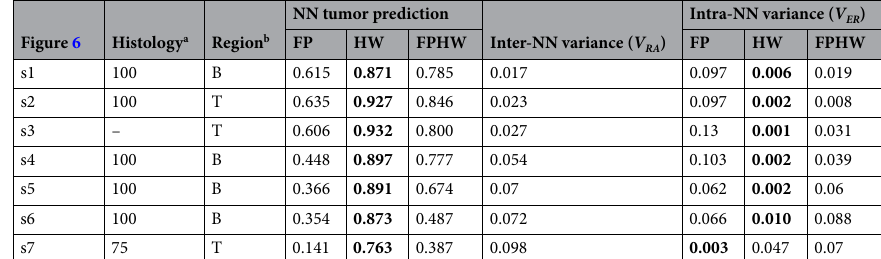
Table 6. Using variance in predicted tumor likelihood amongst the three NN configurations (inter-NN variance, V ER ) to identify tumors predicted by at least one but not all NNs. Significant inter-NN variance (see Fig. 5B, V ER > 1σ) occurred in 7 targets, all from tumor or boundary regions. The highest NN tumor probability for each target appears in bold. NNs using only FP inputs predicts 3 of these targets contain tumor, but with relatively low probabilities ( P Tumor = 0.62 ± 0.02, N = 3). FPHW using the full nine inputs predicts 5 of the 7 targets contain tumor and produces higher probabilities ( P Tumor = 0.78 ± 0.06, N = 5). The NNs trained only on HW data predict all 7 of these targets contain tumor. HW NNs generated the highest tumor likelihood probabilities ( P Tumor = 0.88 ± 0.06, N = 3). The variation in the output of each stochastic NN (train-test cycle repeated 10 times with random weight restarts) provides an intra-NN variance or V RA for each of the three NN configurations. Six of the seven HW NNs exhibits the least variance in their predictions (V RA between 0.001 and 0.10). One a single target (s7) NN FP exhibits minimal variance across ten trials ( V RA ~ 0.003) while generating a low tumor probability ( P ~ 0.141). For target s7 HW predicts a tumor likelihood of P ~ 0.763 with V RA = 0.047. a Pathologist target labels in Fig. 6. Pathologist estimate of likelihood probe would strike tumor tissue in 1 mm 2 region around laser. b Macroscopic (1X) visual assessment of spectra collection sites as tumor (T), healthy (H), or boundary (B)